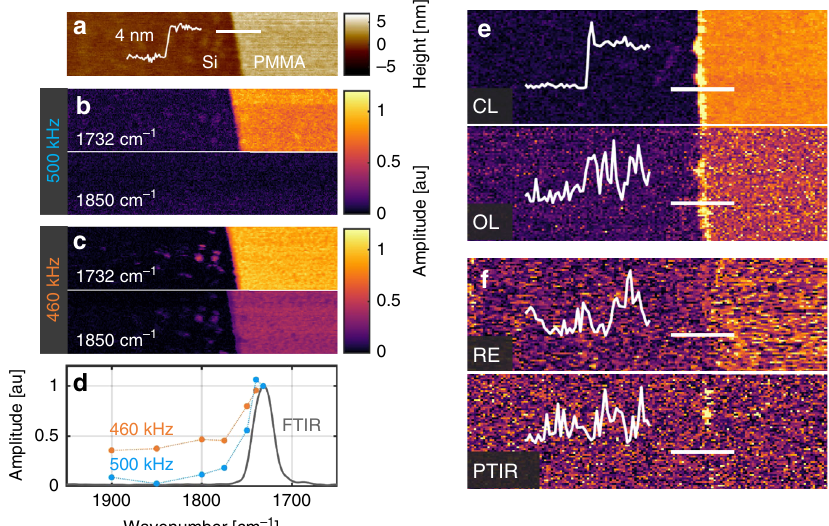
Fig. 5 Mapping Molecular Information of Nanothin Materials on Silicon. a Height map of a 4 nm thick PMMA fi lm on Silicon. b Closed-loop (CL) baseline corrected infrared maps of 1732 and 1850 cm − 1 of the 4 nm fi lm collected off resonance at 500 kHz. c Same measurement as ( b ) collected at 460 kHz near the cantilever ’ s 3rd resonance mode. d Magnitude of the PMMA fi lm signal extracted from CL hyperspectral images compared to FTIR. CL image contrast recorded near cantilever resonance had increased sensitivity (i.e., lower substrate noise) but also additional signal uncorrelated with the local PMMA absorption which was attributed to photo-induced sample acoustics. e Comparison of CL and OL maps at 1732 cm − 1 . Line pro fi les reveal improved signal to noise ratio (SNR) for CL operation. The color scale for the OL measurement was scaled by a factor of 2 due to the increase noise. f Same maps as ( e ) using previous state-of-the-art Resonance Enhanced (RE) and Photo Thermal Induced Resonance (PTIR) methods. For RE measurements, the 3rd resonance mode was tracked using the commercial Nano-IR2 software. Overall this slowed acquisition time down by a factor of 2.5 in addition to worse performance when compare to CL. For PTIR measurements, coaveraging was set to produce a pixel rate equivalent to the CL and OL